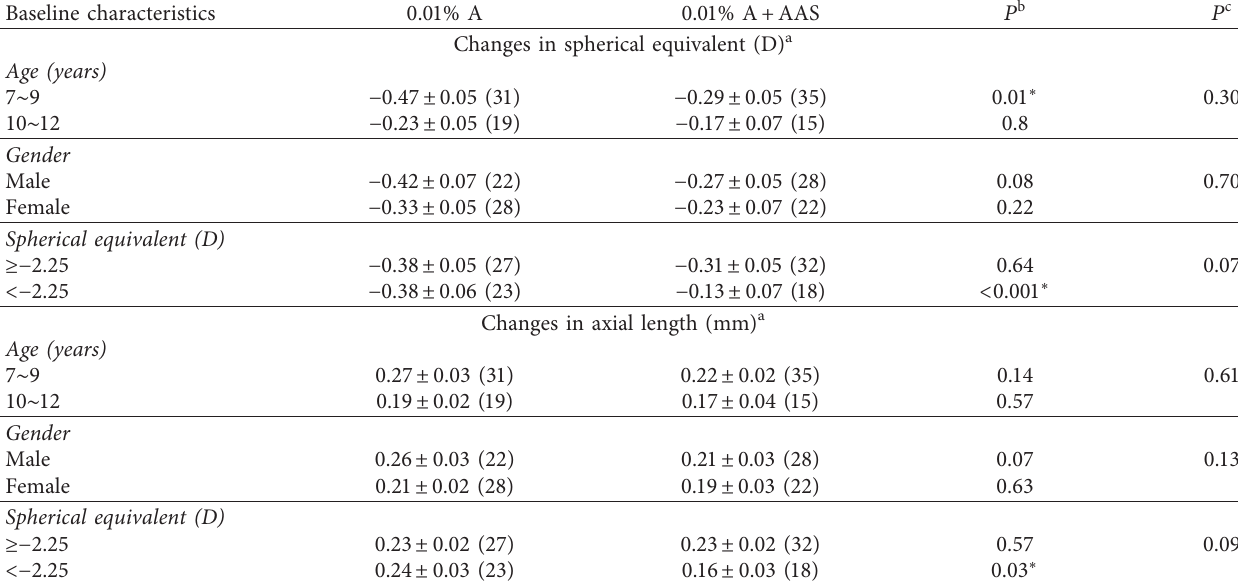
Figure 3: Adjusted mean change of myopia progression from baseline to 6 months. SE: spherical equivalent; AL: axial Table 3: Adjusted 6-month change in myopia progression stratified by baseline characteristics.